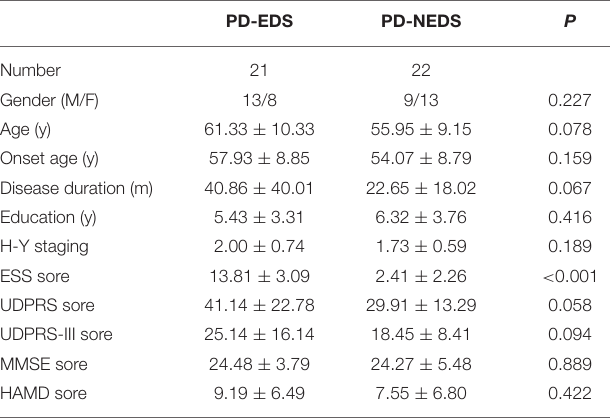
TABLE 1 | Demographic and clinical characteristics of the PD-EDS and PD-NEDS group (Mean ± SD).